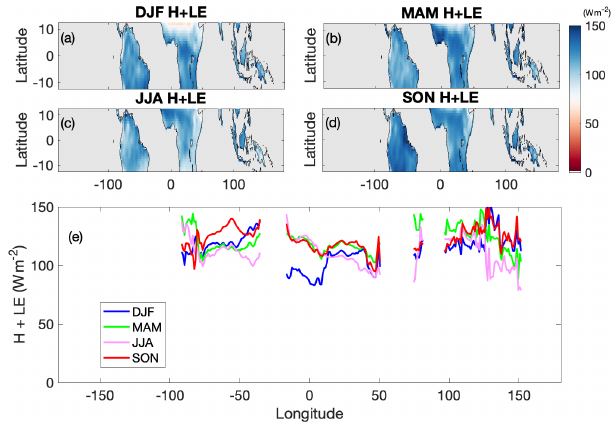
Figure 9. Same as Fig. 4 but for sea-level surface moist static energy flux, the sum of sensible heat flux (H) and latent heat flux